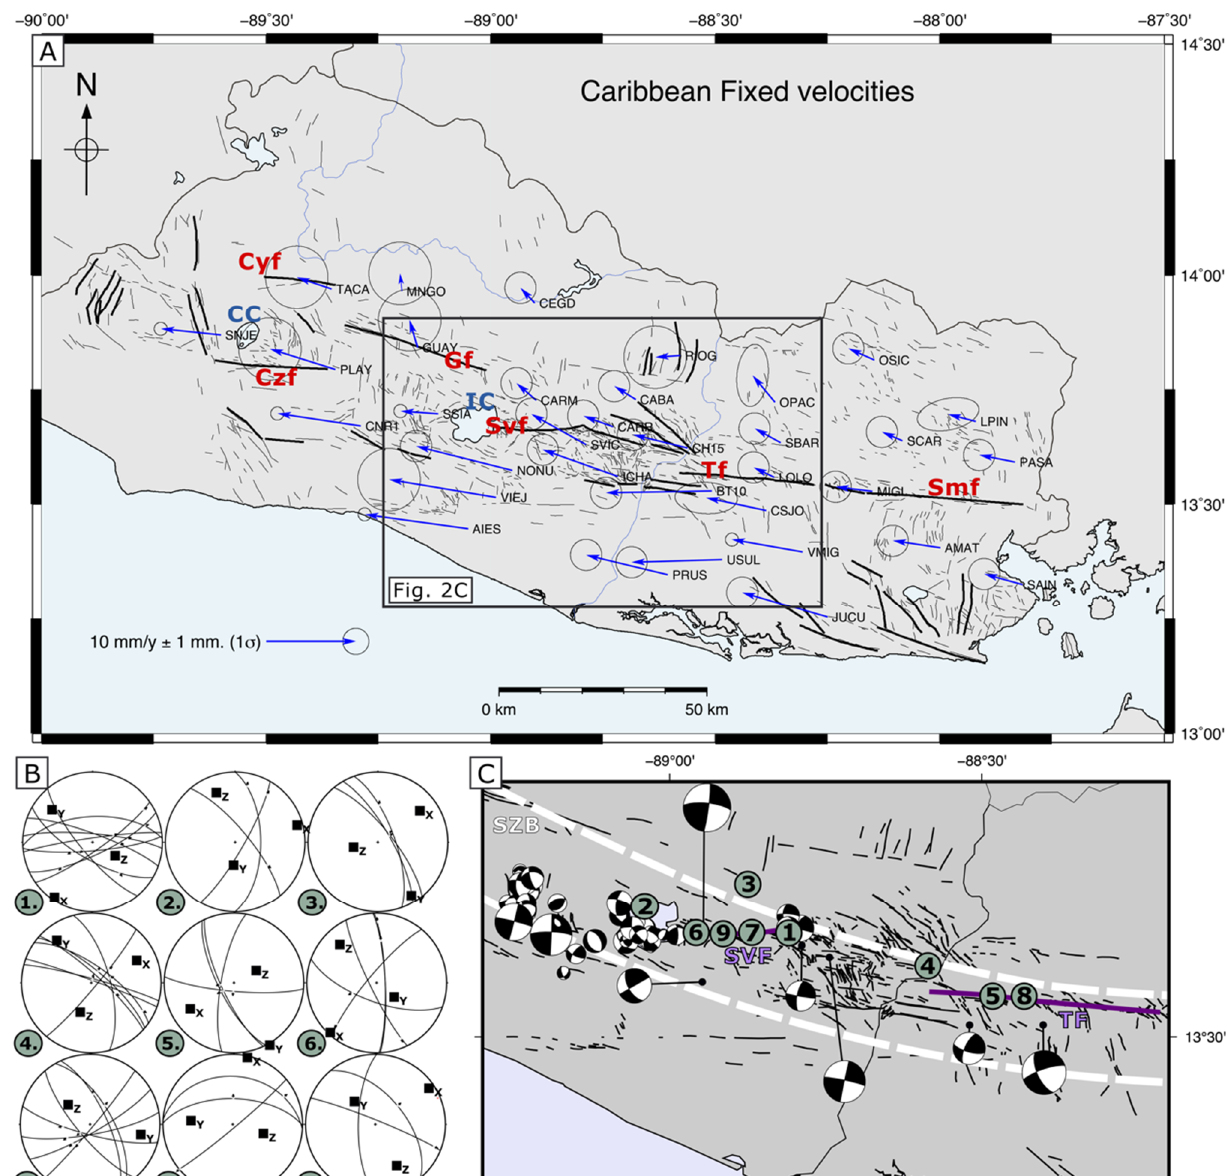
Figure 2. ( A ) El Salvador Fault Zone (ESFZ): thicker black lines are the main faults; thinner gray lines are minor faults. Arrows are GPS velocities from the ZFESnet GPS network [17]. Text in red corresponds to the fault names: Cyf = Comecayo Fault; Czf =Coatepeque-Zapotitán Fault; Gf =Guaycume Fault; Svf = San Vicente Fault; Tf = El Triunfo Fault; Smf = San Miguel Fault. Labels in blue are Calderas: CC = Coatepeque Caldera; IC = Ilopango Caldera. ( B ) Equal area lower hemisphere projection of fault slip data measured in the study area. X, Y and Z are the three principal axes of an infinitesimal strain ellipsoid determined for each site (see Section 3), with the location of each site shown by numbers in Figure 2C. ( C ) Focal Mechanisms available in the study area, whose size depends on earthquake magnitude. Numbers indicate the site of the fault slip data collection. Letters highlighted in purple correspond to San Vicente and El Triunfo faults.